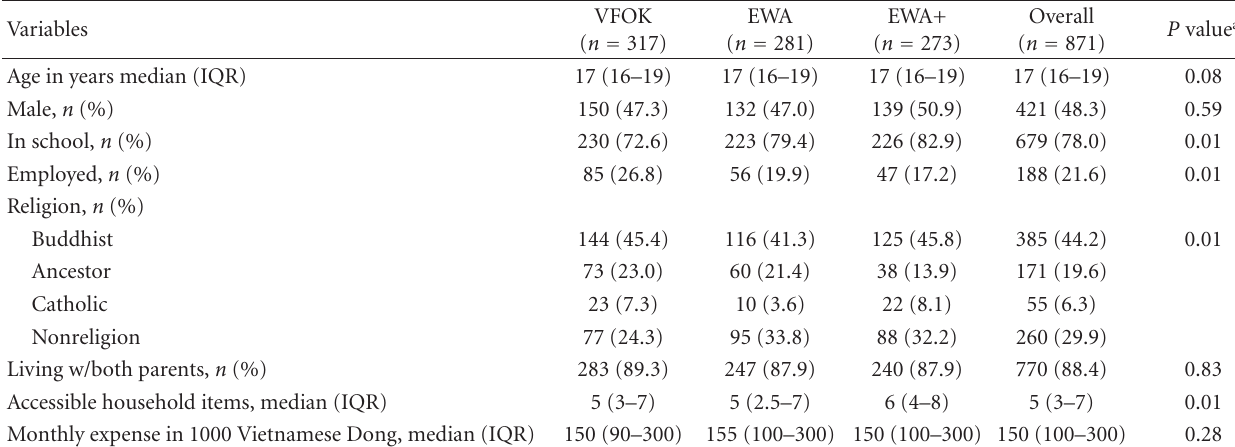
Table 1: Baseline demographic characteristics by intervention groups.